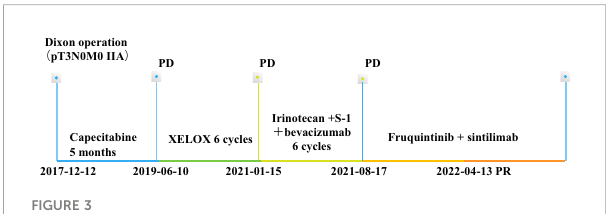
FIGURE 3 Timeline of the treatment processes. XELOX, oxaliplatin + capecitabine. PD, progressive disease, PR, partial response.